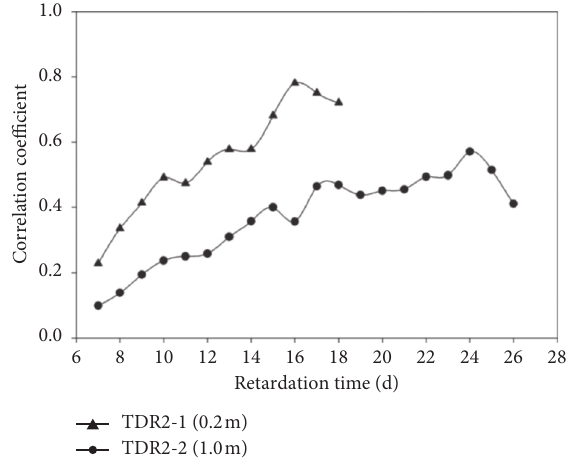
Figure 5: Correlation relationship between VWC and